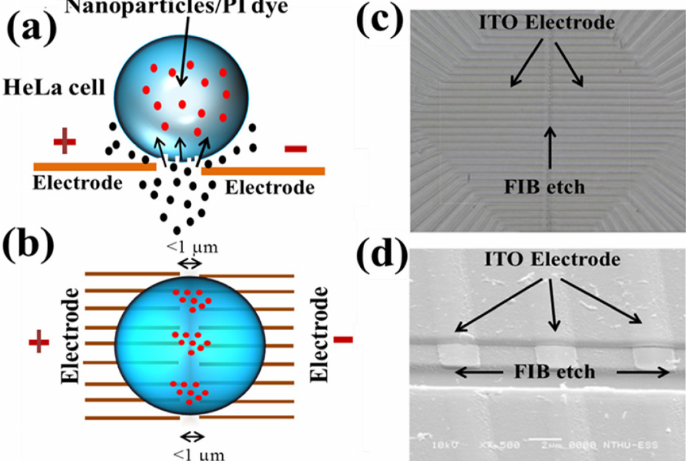
Figure 14. Localized single cell membrane electroporation (LSCMEP) device ( a ) localized electroporation microelectrodes optical microscope image of ITO microelectrodes; ( d ) scanning electron microscope image of ITO microelectrodes with microchannel. Permission to reprint obtained from Springer [27].